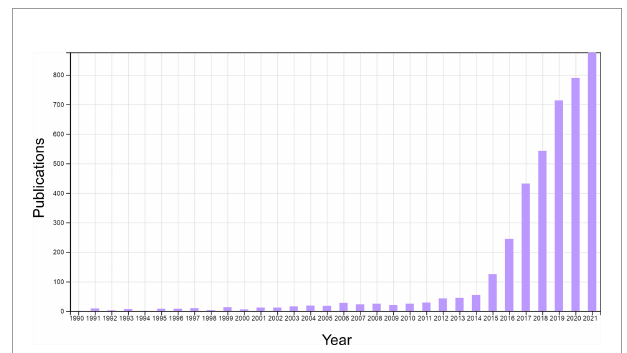
FIGURE 1 | ctDNA publications: Number of publications with ctDNA as a topic between 1990 and 2021, collected in Web of ScienceTM